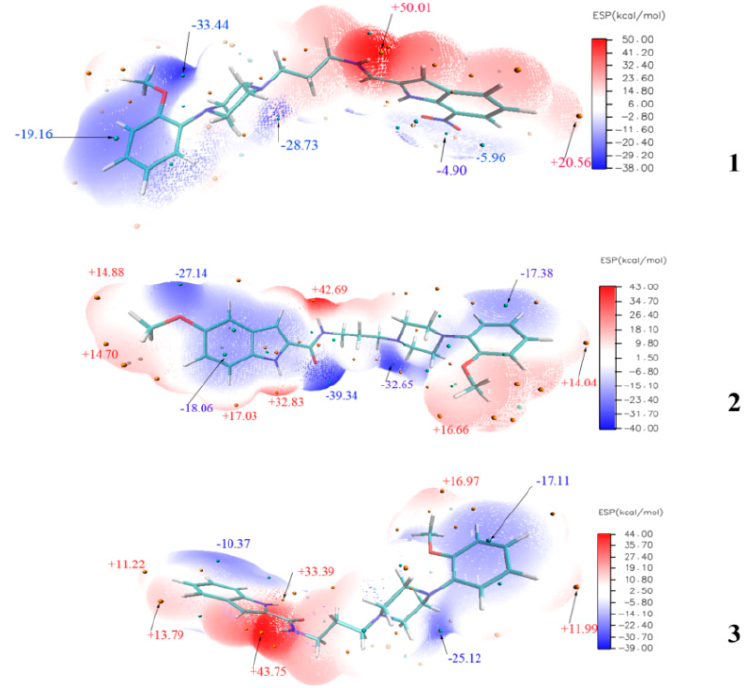
Figure 10. MEP surfaces of compound 1 , 2 and 3 .